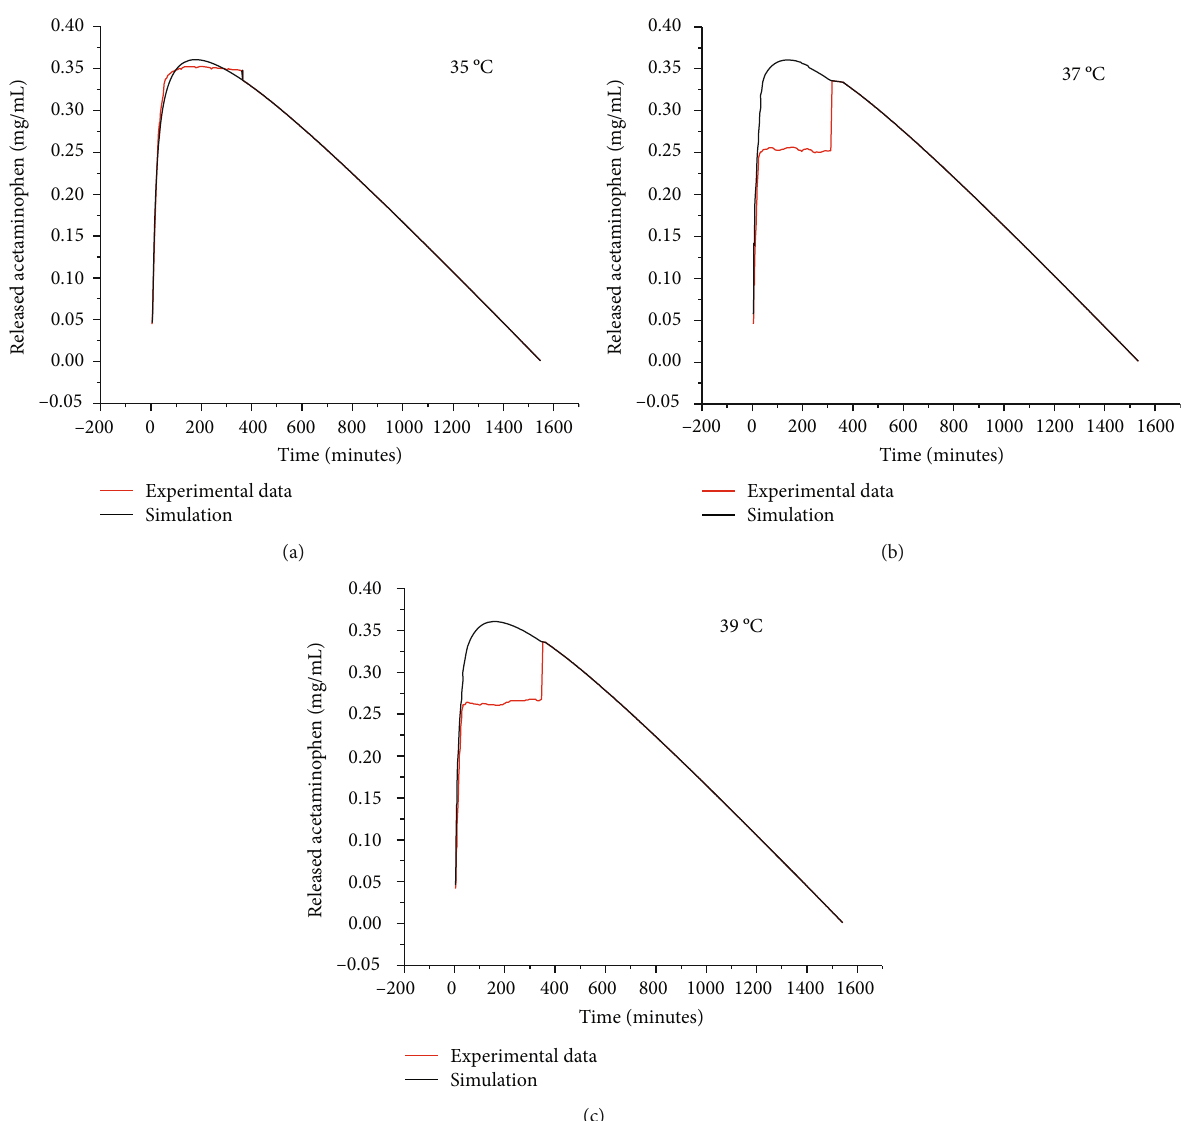
Figure 9: Concentration vs. time curves for the release of acetaminophen from HPC/PAAm gel in PBS at (a) 35, (b) 37, and (c) 39 ° C. Table 2: Simulation statistics for the release of acetaminophen